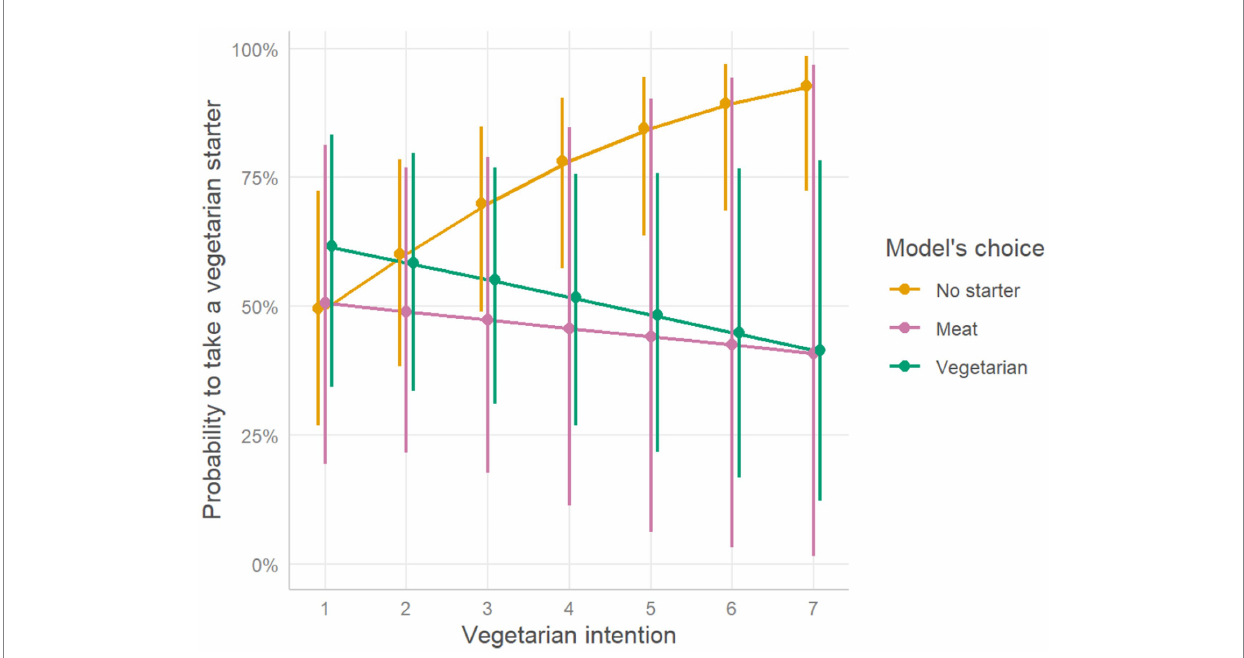
FIGURE 4 Probability to take a vegetarian starter, as function of vegetarian intention. The plot represents estimated effects of intentions on the probability to take a vegetarian starter among participants who took a starter, for different model’s choices. Oblique lines represent the estimated marginal mean probability of taking a vegetarian starter, as opposed to taking a meat starter, while the error bars represent 95% confidence intervals based on estimated standard errors (+/ − 1.96